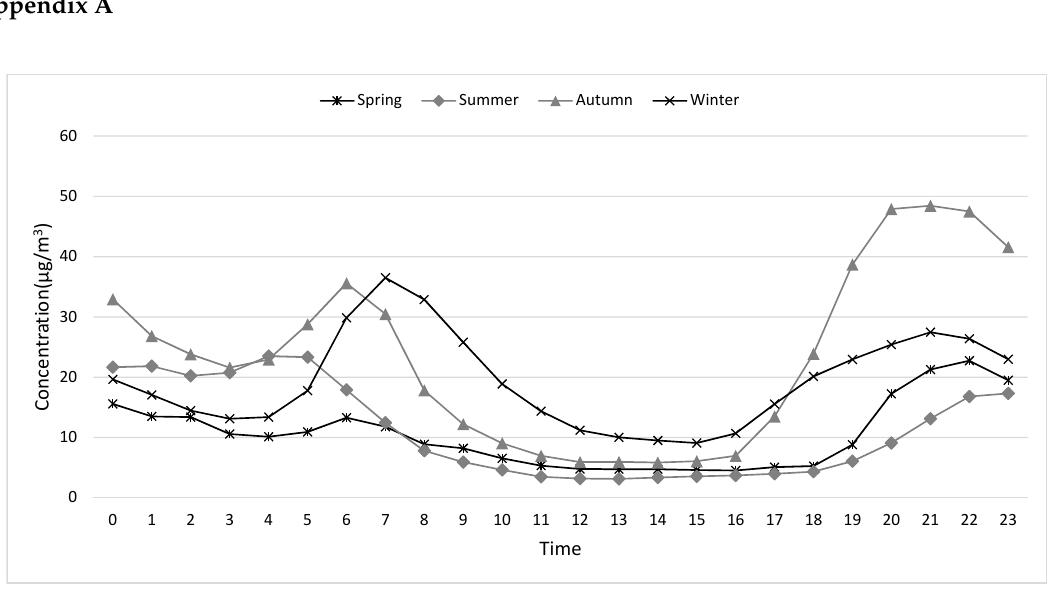
Figure A1. Seasonal nitric oxide concentration variation in Changchun in 2013–2017.